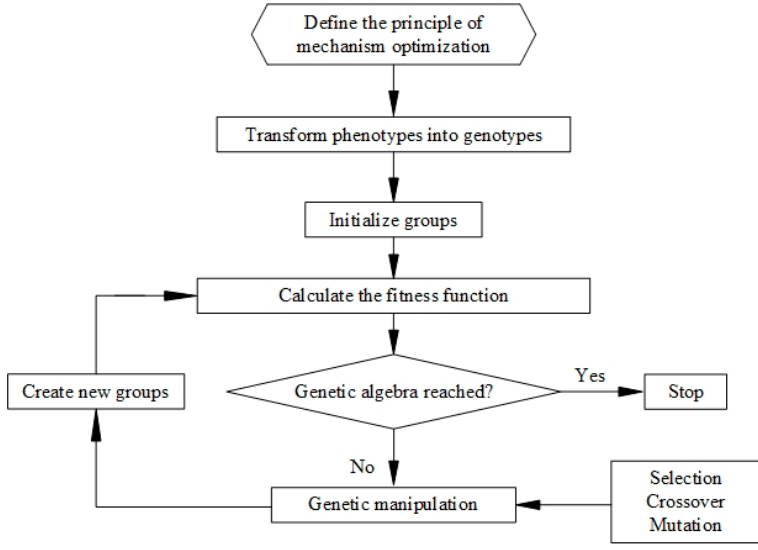
Figure 4. The genetic algorithm optimizing solution steps.